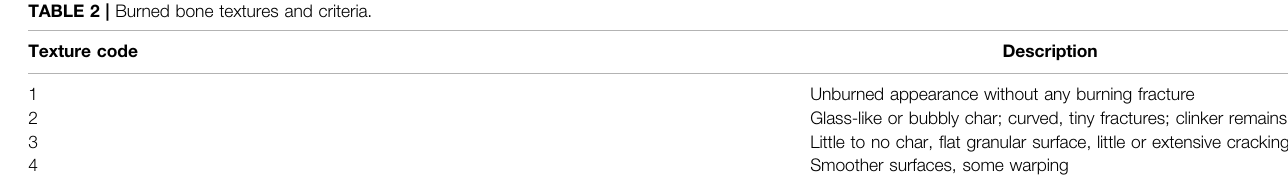
TABLE 2 | Burned bone textures and